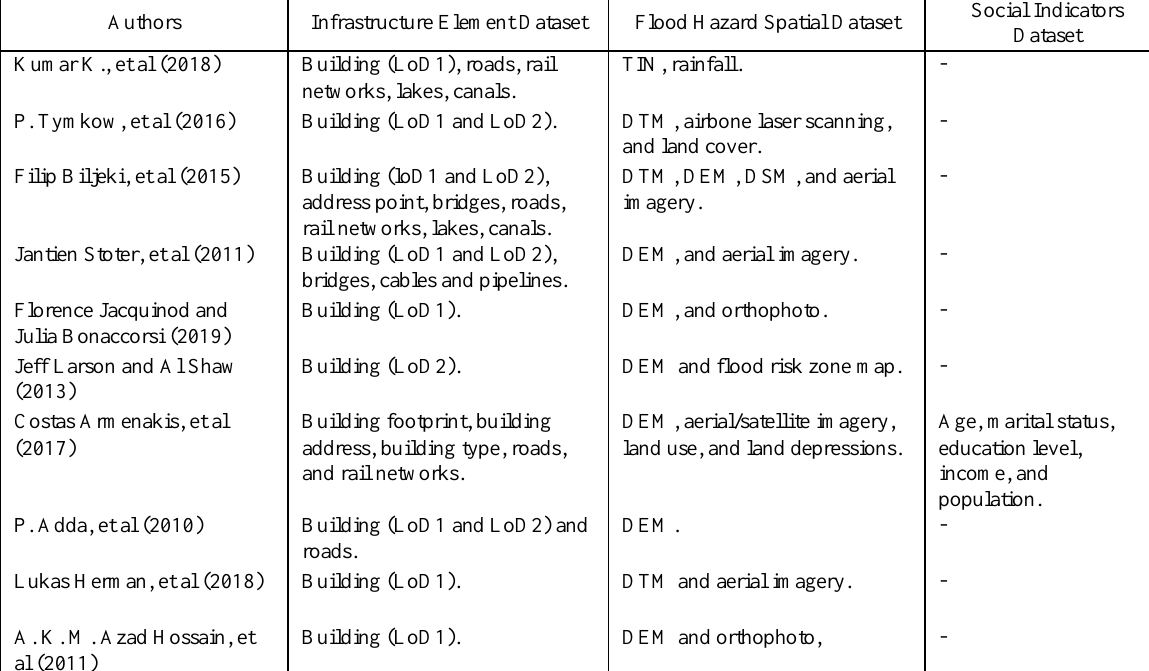
Table 5. Summary of dataset used in previous study